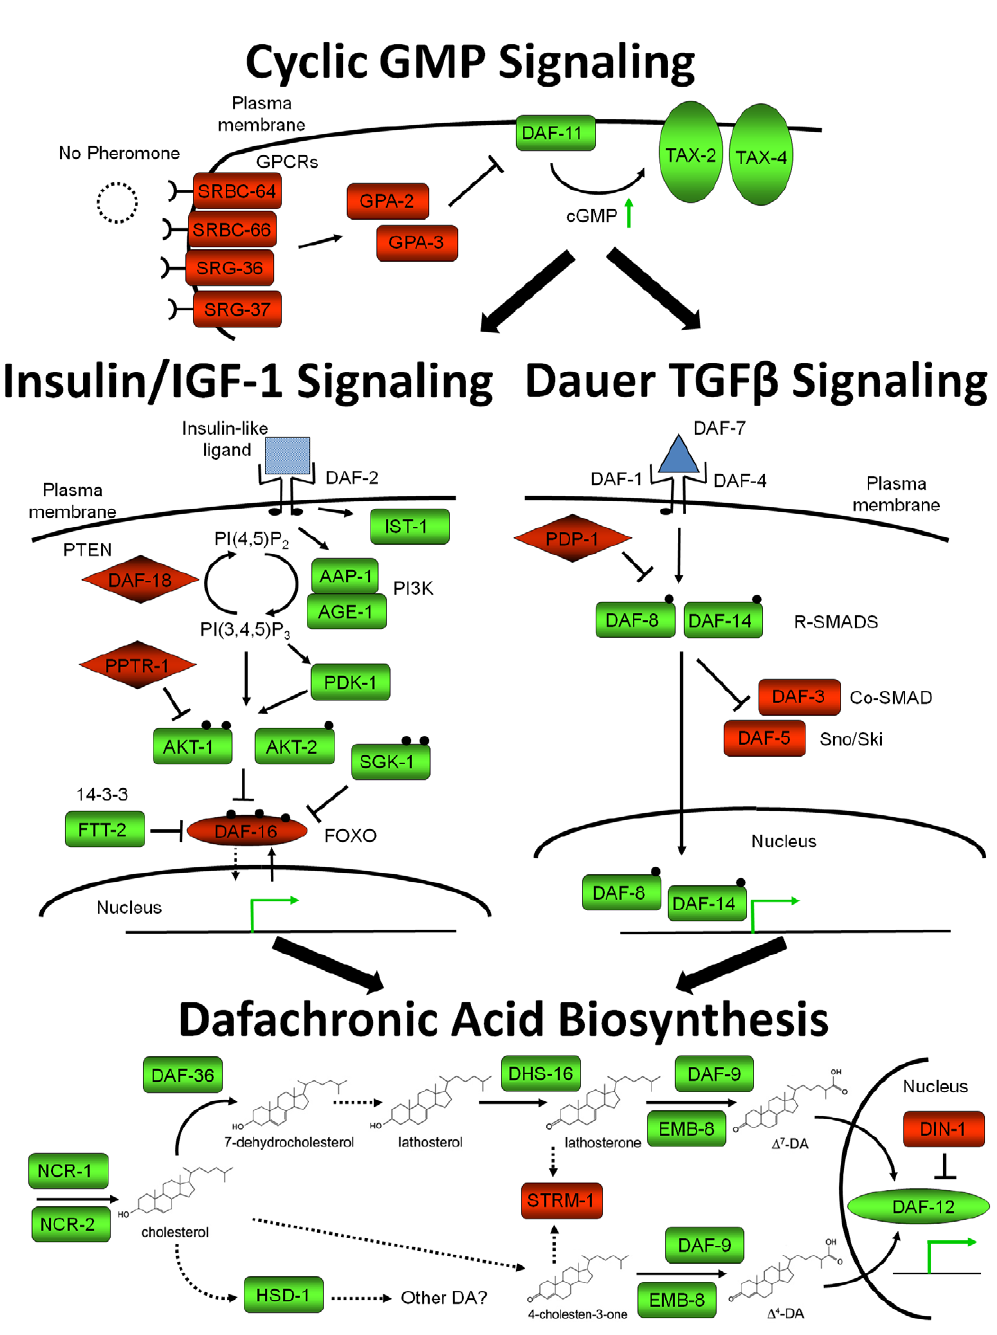
Figure 2. Caenorhabditiselegans dauer pathways during reproductive development. Four developmental pathways regulate C. elegans dauer entry and exit: a cyclic guanosine monophosphate (GMP) signaling pathway, an insulin/insulin-like growth factor 1 (IGF-1) -like signaling pathway, a dauer transforming growth factor b (TGF b ) pathway, and a nuclear hormone receptor (DAF-12) regulated by a class of steroid ligands known as dafachronic acids (DAs). This simplified model depicts the four pathways under conditions favoring reproductive development and repression of dauer arrest. Proteins in light green are ‘‘active,’’ while proteins in dark red are ‘‘inactive.’’ Black circles represent phosphorylation sites and diamond-shaped boxes represent phosphatases. Green arrows represent either increases in metabolite concentration or increases in gene transcription. Solid black lines represent well-established pathways, while dashed lines represent putative pathways. Adapted from [12,54,111,129].